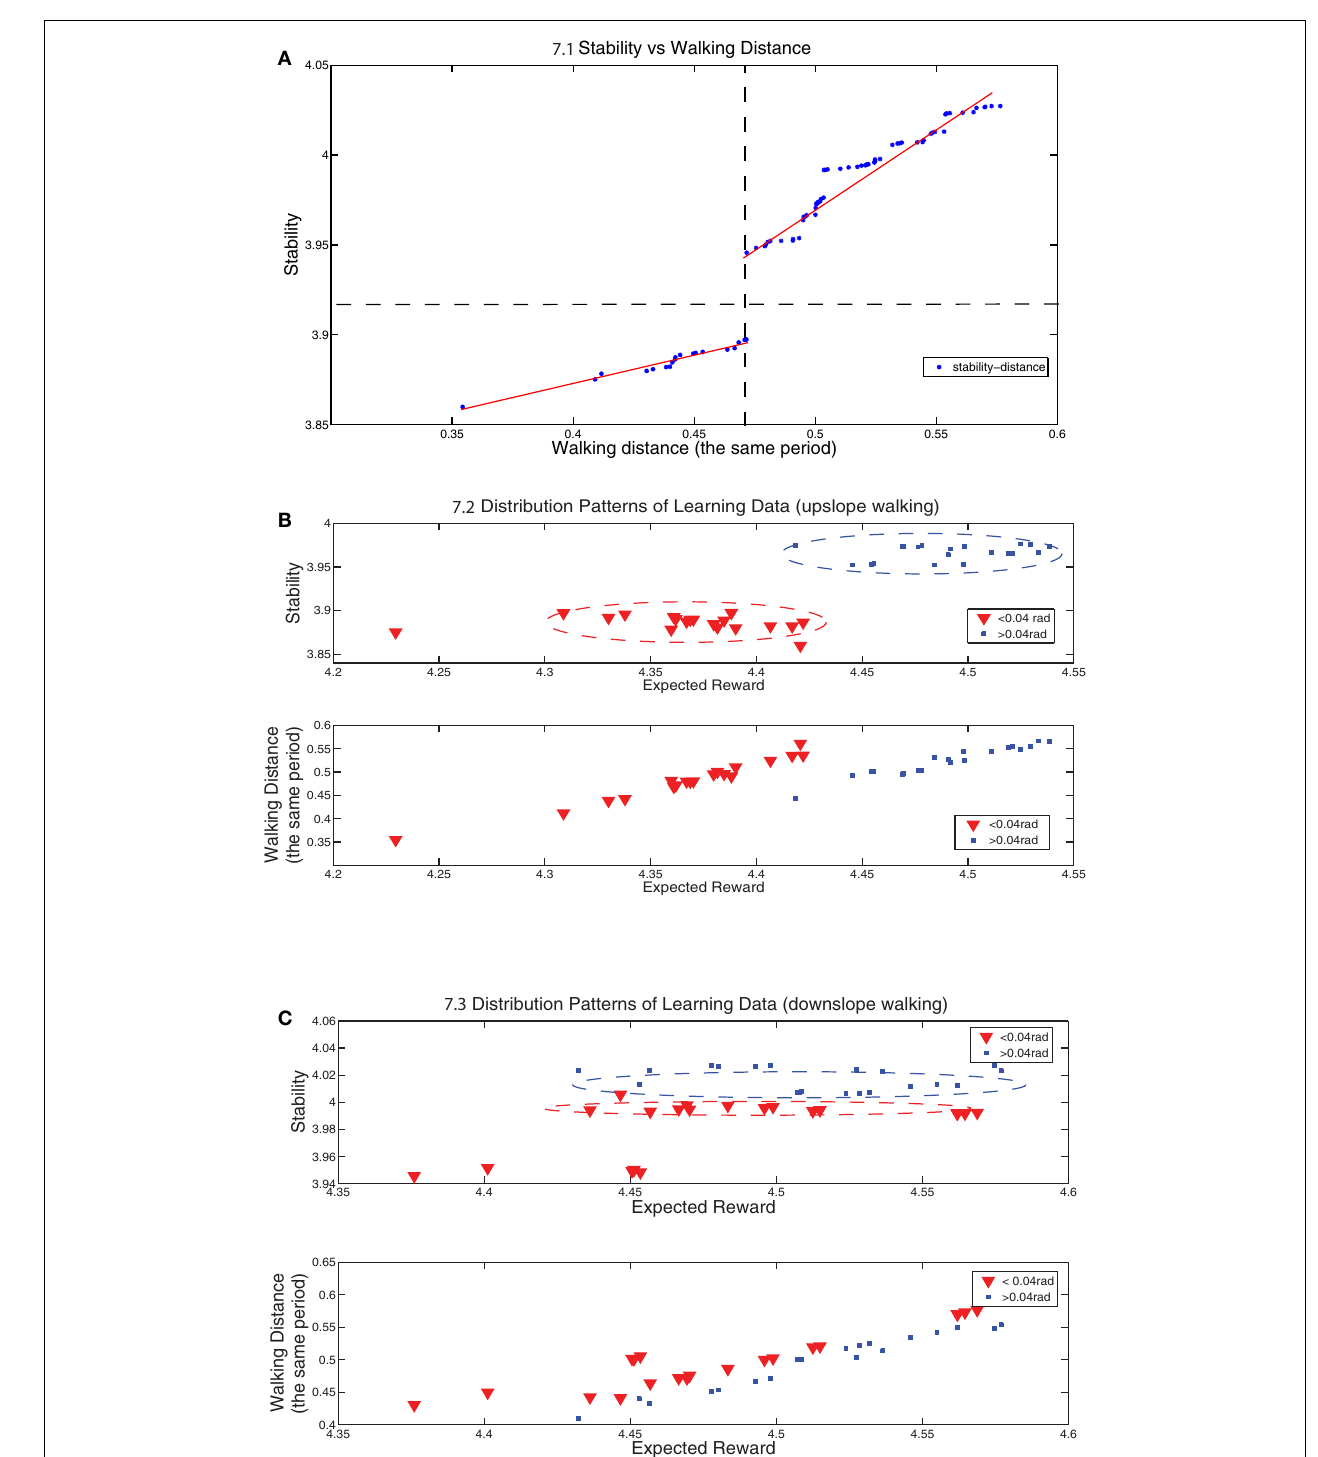
hand-drawn lines. (B,C) show the distribution points of stability vs reward and walking distance vs reward for upslope and downslope walking respectively. The red-triangle dots represent the results for the cases in which | slope | < 0.04 rad and the blue-plus dots represent the results for | slope | > 0.04 rad . Note that the walking distance is measured always for the same period and it also reflects the speed of